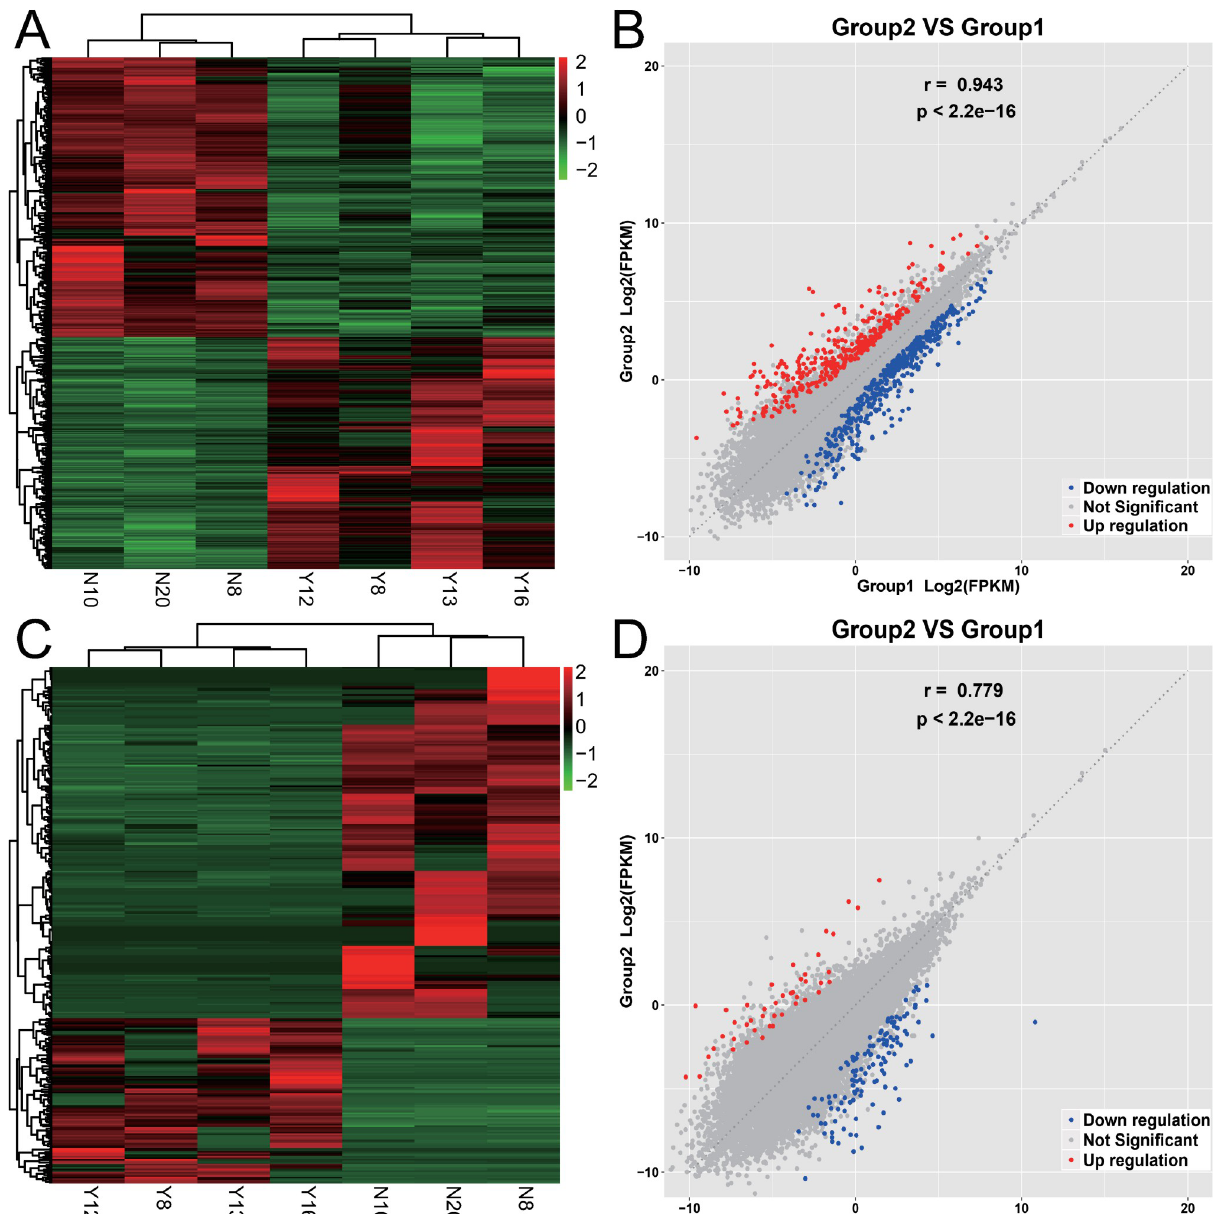
Fig 2. Expression differences of mRNAs and lncRNAs between normal gallbladders and gallbladders with chronic inflammation. Group 1 is normal gallbladder including N8 N10 N20; Group 2 is gallbladder with chronic inflammation including Y8 Y12 Y13 Y16. (A) The heatmap figure of mRNA expression between the two groups. The deeper the red, the higher the expression, and the darker the green, the lower the expression. (B) The correlation scatter diagram of mRNA expression between the two groups, the red dots are the upregulated mRNAs of gallbladder with chronic inflammation relative to the normal gallbladder, the blue dots are the downregulated mRNAs, and the gray dots indicate the differences are not significant. (C) The heatmap figure of lncRNA expression between the two groups. (D) The correlation scatter diagram of lncRNA expression between the two